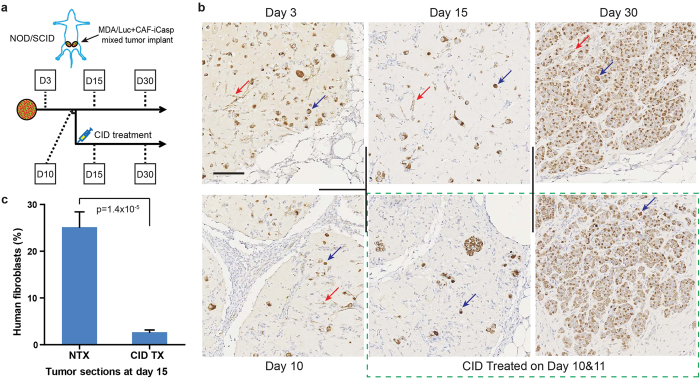
In vivo elimination of suicide gene-engineered stromal cells.(a) NOD/SCID mice were inoculated with MDA-Luc + CAF-iCasp tumors at mammary fatpads on both flanks, and half of the population was injected with CID homodimerizer at day 10 and 11. Animals were sacrificed on dash-line indicated days and tumor were stained with a human mitochondria-specific antibody. (b) Human mitochondria staining of xenograft tumor sections where MDA/Luc and CAF-iCasp cells were co-implanted into the mammary fatpads of NOD/Scid mice. Fibroblastic human CAF cells remain visible 30 days after implantation in the NTX condition, and hardly seen in the tumors from mice hosts treated with CID injection on day 10 and 11. Scale bar: 100 μm. (c) Morphology-based quantification shows dramatic reduction of human fibroblasts in tumors treated with CID drug (p = 1.4 × 10−5, Student’s t-test). Total images analyzed: NTX: n = 13; CID TX: n = 14. For in vivo study, N = 5 animals per endpoint, per condition. Error bars: standard error of the mean (SEM).